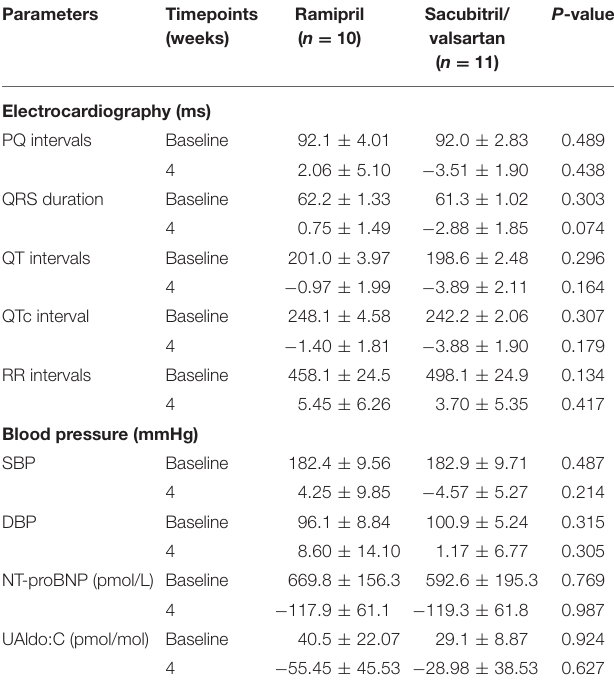
TABLE 3 | Effects of ramipril and sacubitril/valsartan on electrocardiographic parameters, blood pressure, and N-terminal pro-B-type natriuretic peptide